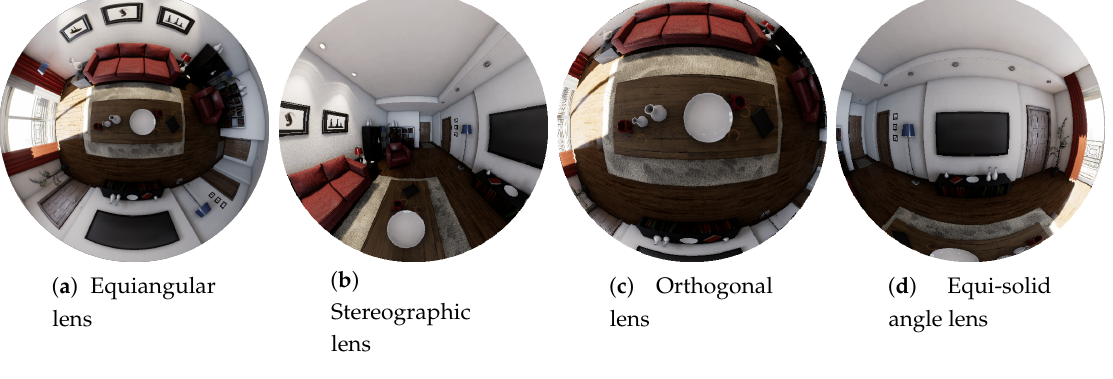
Figure A4. Lit mode.